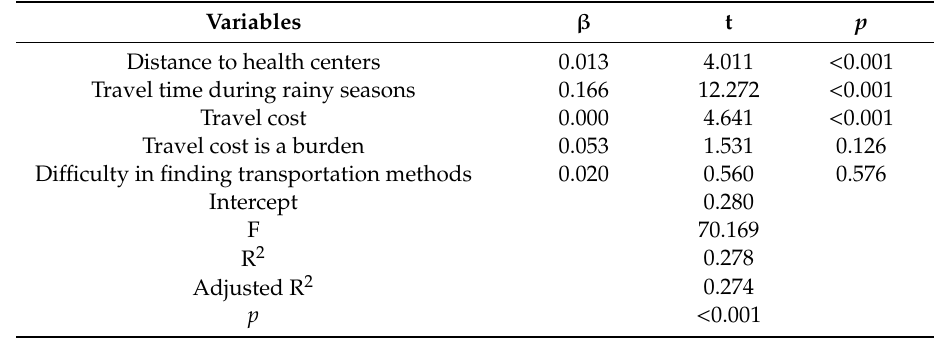
Table 6. Multiple regression analysis of the e ff ects of selected variables on travel time in minutes ( N =